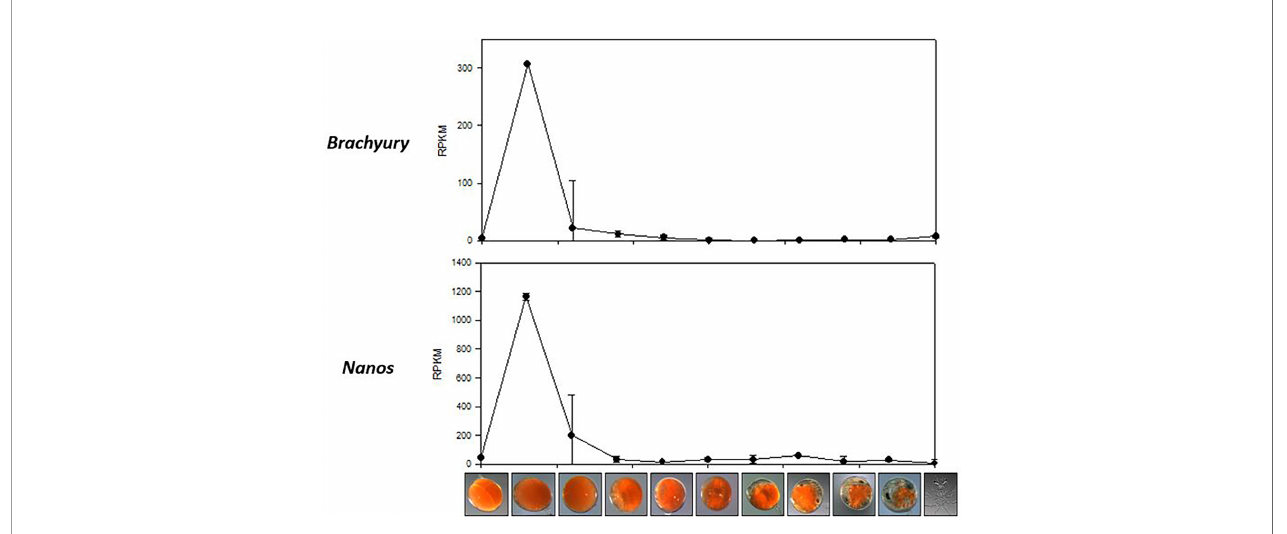
FIGURE 4 | Expression of two gastrula-speci fi c genes, Brachyury and Nanos across the 11 embryonal development stages of Panulirus ornatus , represented as